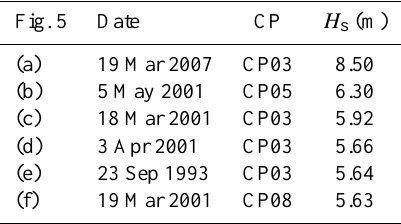
Table 3. Six of the most extreme wave events on record and their associated CPs for the period 1992 to